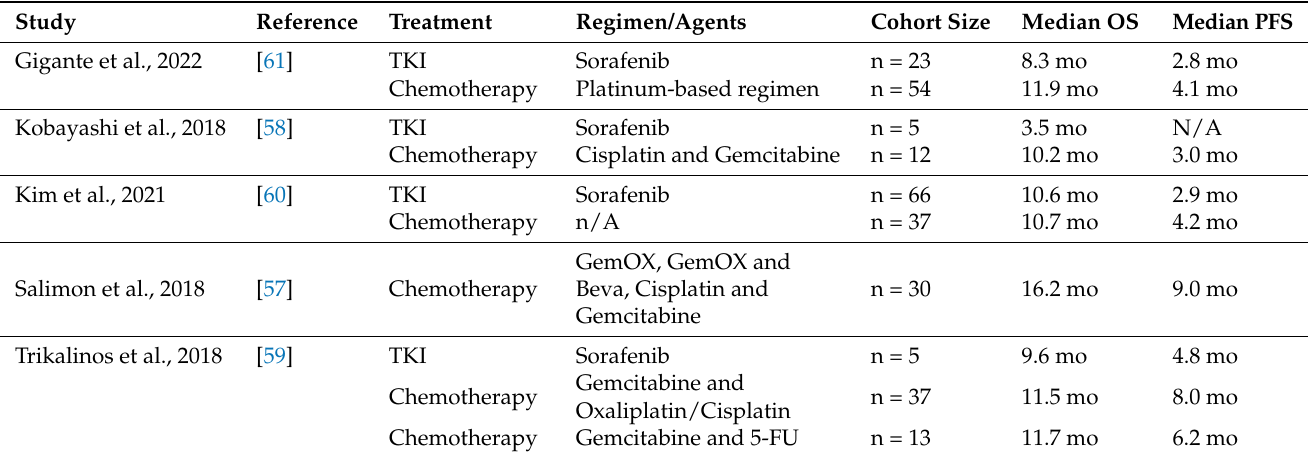
Table 3. Overview of the largest published retrospective studies to date comparing treatment in advanced or metastatic hepatocellular